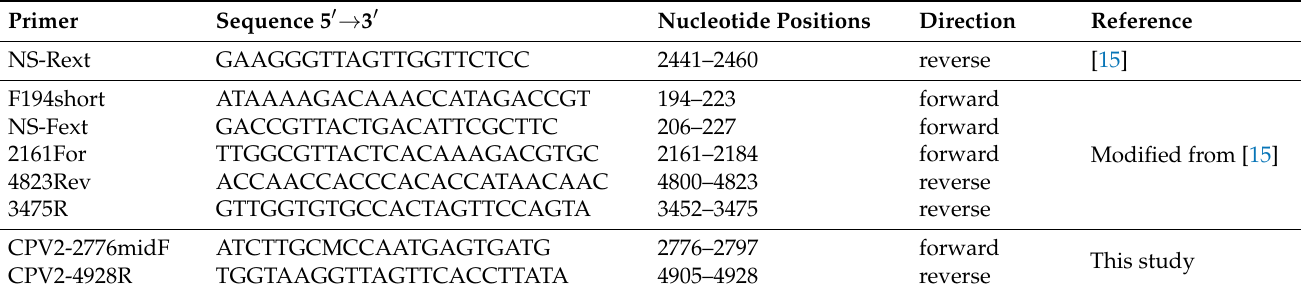
Table 1. Primers used within the study.